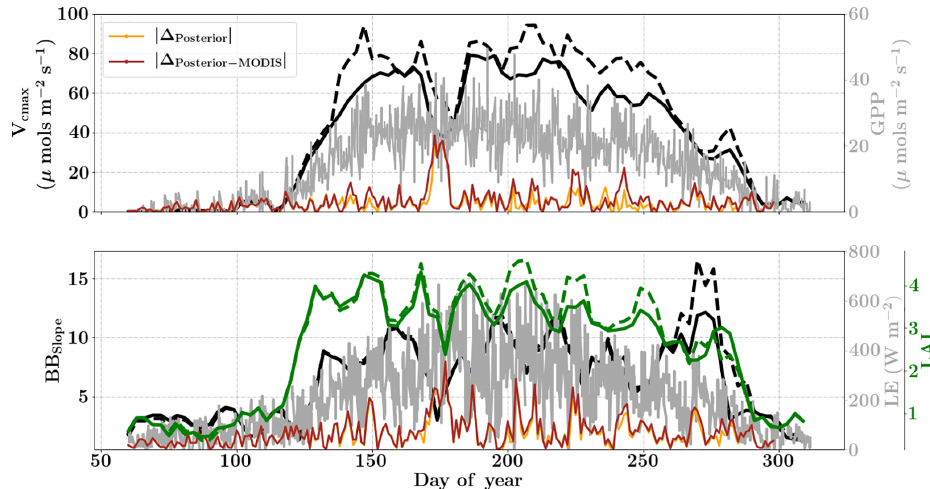
Figure 10. Figure showing the seasonal variability in retrieved parameter values of V cmax , BB slope and LAI for the Missouri Ozark site using a 3-day moving window inversion approach for the year 2009. The actual points in the time series (grey lines) of the GPP and LE fluxes used as the target observations ( Y ) for the moving window inversion approach are shown in the background. The figure shows the comparison of the retrieved parameters using only GPP and LE fluxes (shown as dashed lines) as well as using a combination of fluxes and MODIS reflectance (shown as solid lines). The results show reasonable trends in the retrieved parameters along with their sensitivity to GPP and LE fluxes across the growing